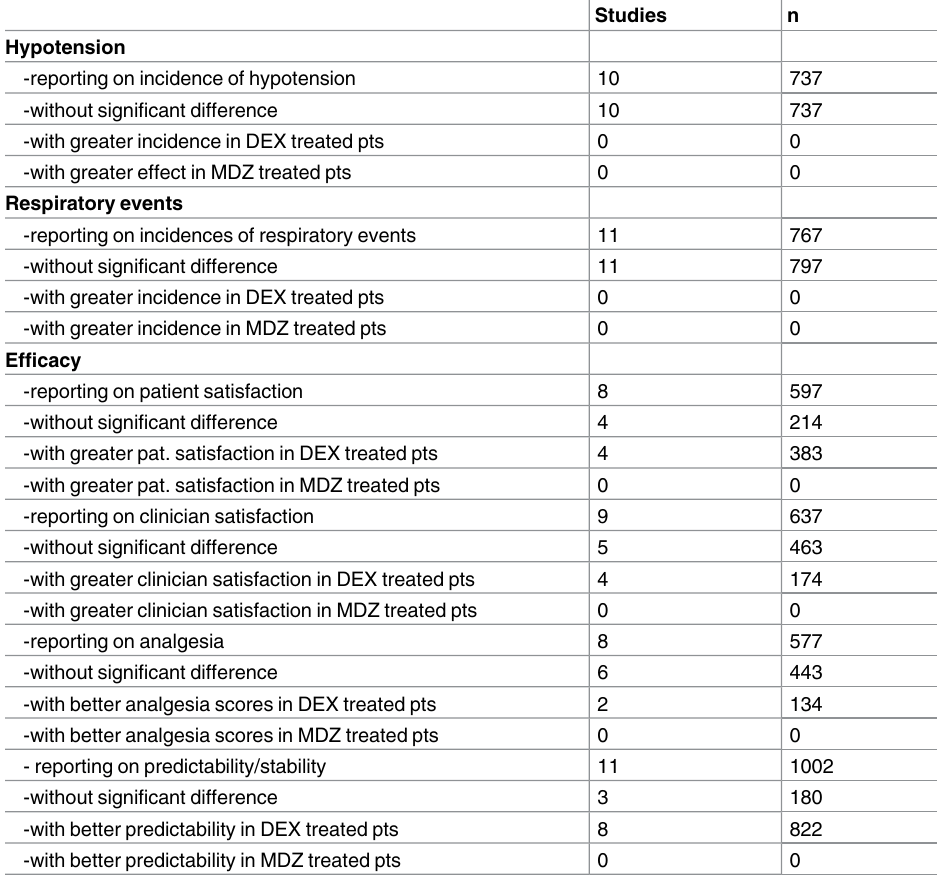
Table 3. Study and outcome